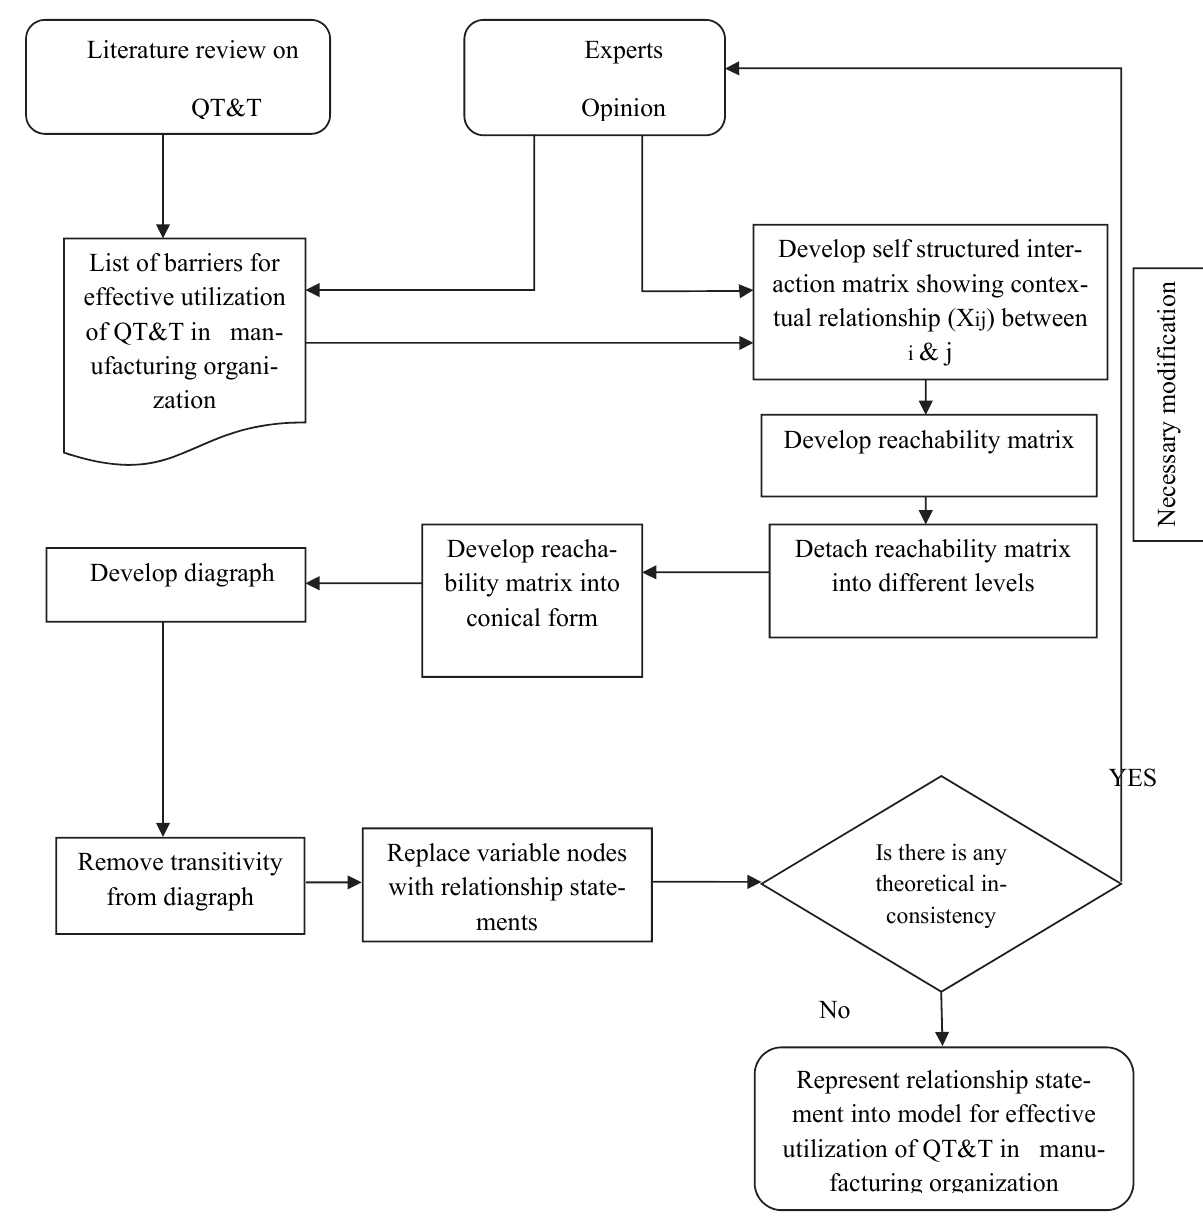
Fig. 1. Process sequence of ISM model (adapted from Govindan et al.,